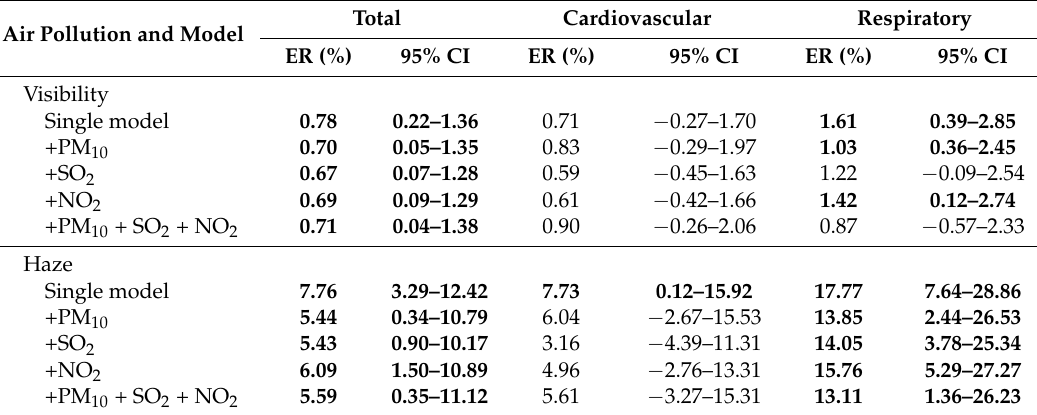
Table 3. Excess risk (ER%) for mortality with per 1 km decrease of visibility at lag day 0 and in haze days at 0–2 lag days, after adjustment for different pollutants.